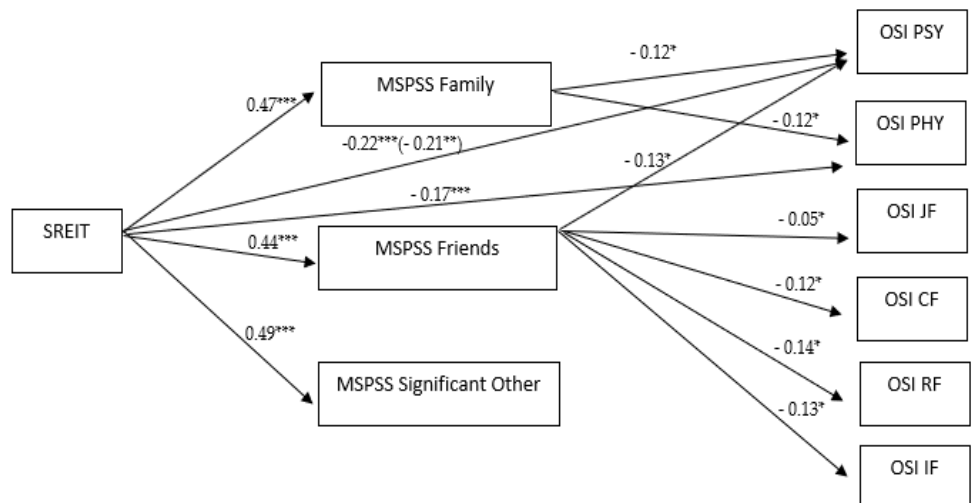
Figure 3. Measurement model testing the relationship between EI and occupational stress through social support. Only significant paths are shown. Direct effects are in parentheses. SREIT: Self- Report Emotional Intelligence Test; MSPSS = Multidimensional Scale of Perceived Social Support; OSI = Occupational Stress Indicator; OSI PSY = Psychological; OSI PHY = Physical; OSI JF = Job Factor; OSI RF = Relational Factor; OSI CF = Career Factor; OSI IF = Work–Home Interface Factor. * p < 0.05, ** p < 0.01, *** p < 0.001.